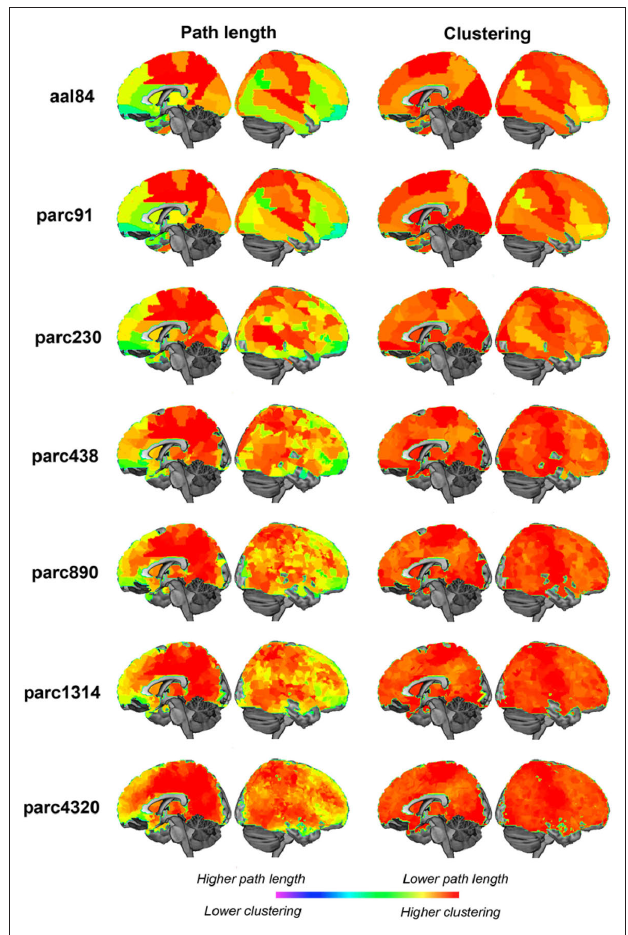
FIguRe 12 | Medial and lateral cortical surface renderings illustrating regional variations in sample mean path length (left) and clustering (right) at each parcellation scale. Path length values have been inverted so that lower values are represented by “hotter” colors.